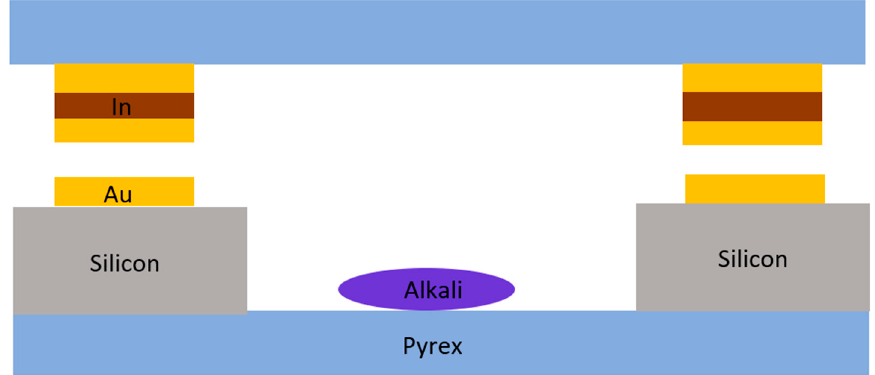
Figure 4. Thin-film-bonded alkali metal vapor cell with an asymmetric structure.